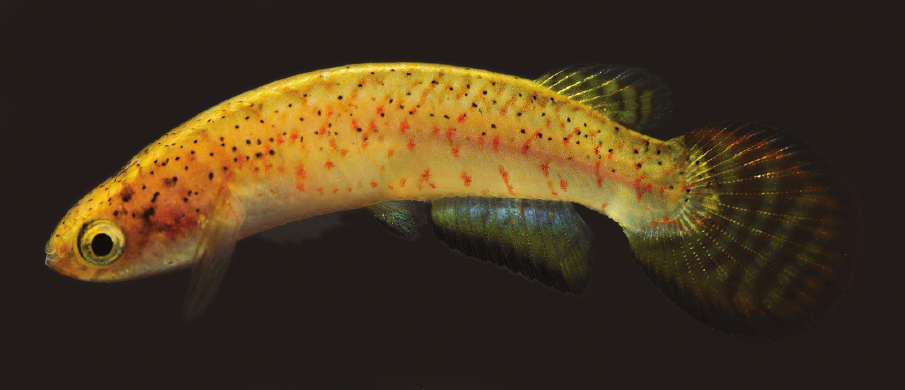
Figure 5. Melanorivulus flavipinnis sp. n., paratype, UFRJ 6882, female, 27.8 mm SL. Photograph by W.J.E.M. Table 2. Morphometric data of Melanorivulus flavipinnis .